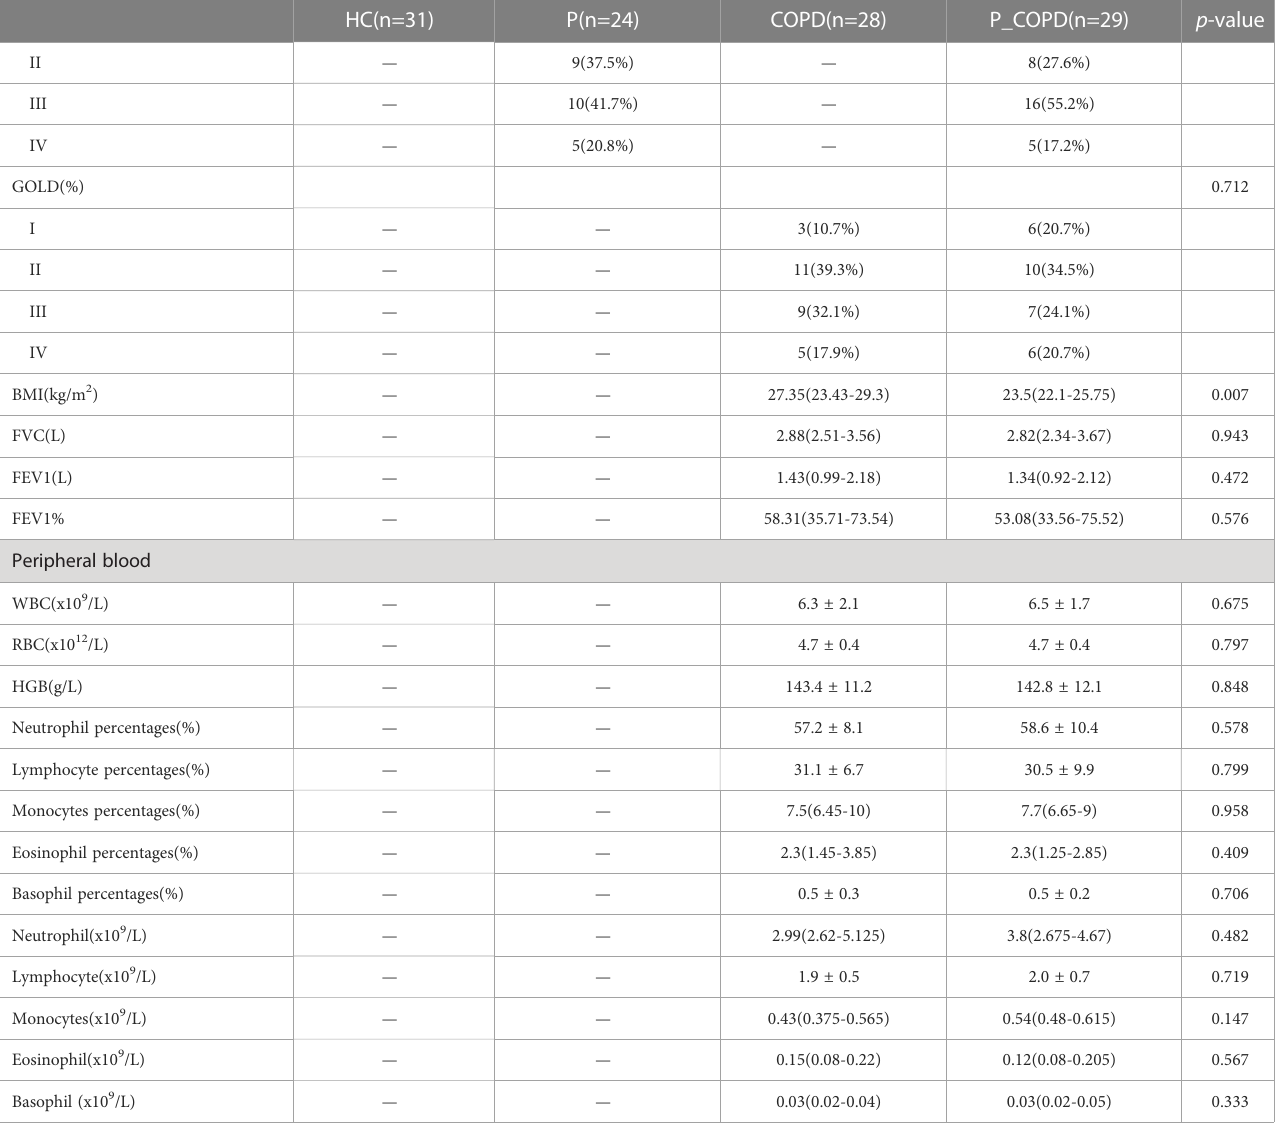
(Figure S4A). There were no signi fi cant differences in the GOLD grade and clinical indicators between the COPD and P_COPD